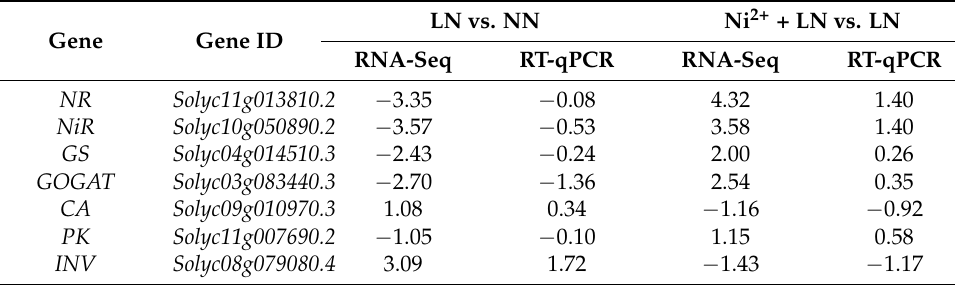
Figure 5. Statistics for 1043 DEGs in the intersection of two comparative groups. Hierarchical clustering ( A ) and KEGG classification ( B ). Table 2. DEGs in the roots of tomato plants in response to Ni 2+ and LN The common DEGs were significantly enriched in C and N metabolic pathways. LN